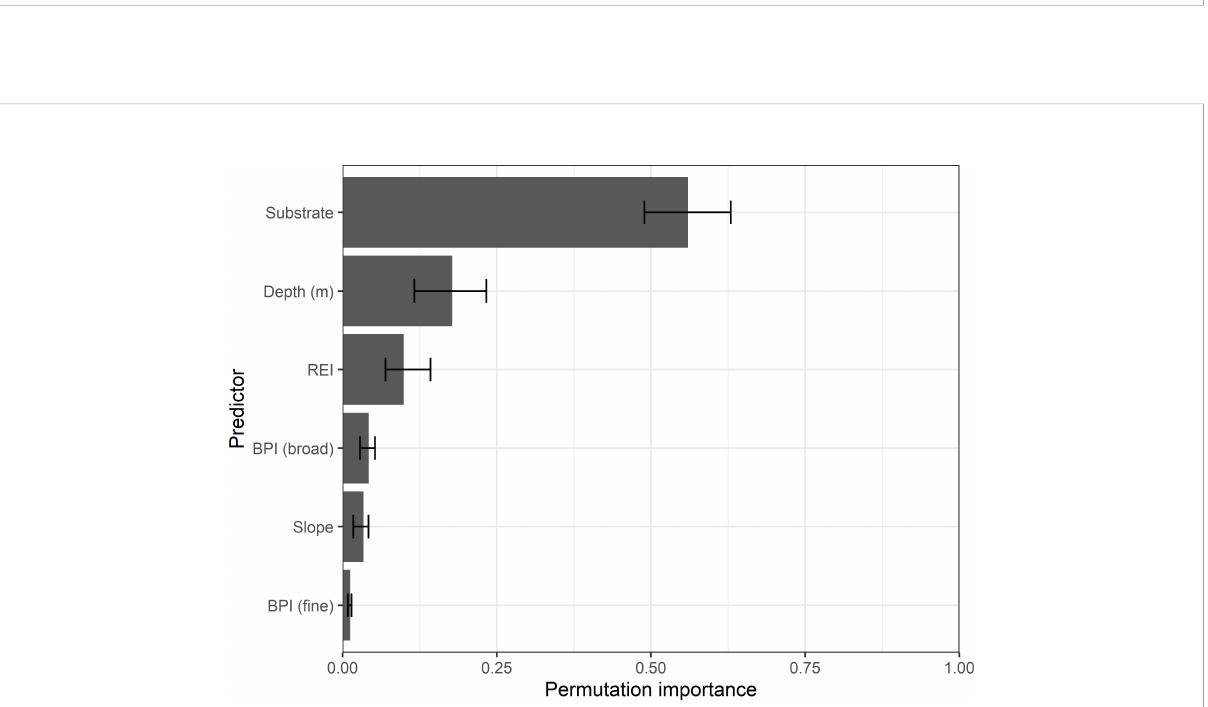
FIGURE 6 Relative in fl uence of 6 environmental predictors on the probability of eelgrass occurrence predicted by the ensemble model. Bars are the mean permutation importance and errors bars the maximum and minimum importance values across 5-cross validation runs. Predictors include categorical substrate type (muddy, sand & mud, sandy, rocky), depth (m), relative exposure to wind-driven waves (REI; unitless), seabed slope (degrees) and 2 bathymetric position indices (BPI; unitless).